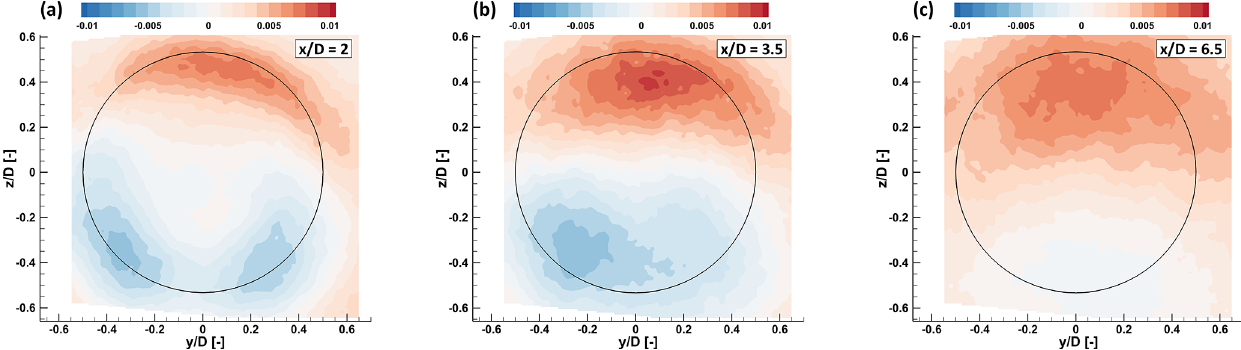
Figure 20. Normalized lateral turbulent flux − v (cid:48) u (cid:48) /U 2 rotor circumference.